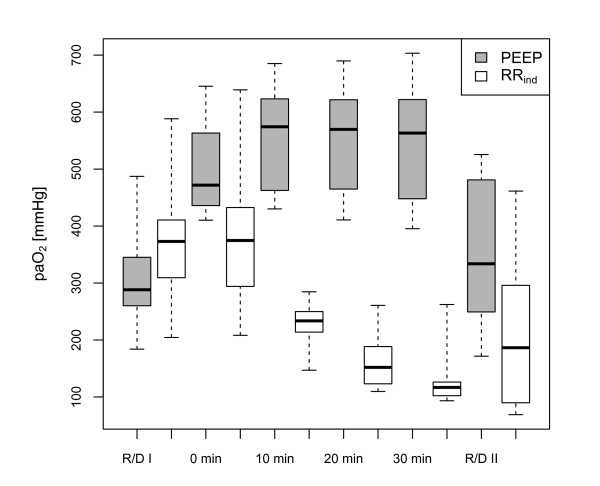
Time chart of the average paO2. Average paO2 (mmHg) after induction (R/D I), within 30 minutes of intervention and after re-induction (R/D II): a significantly decreased oxygenation develops following RRind intervention while PEEP induces a stable lung recruitment (padjusted < 0.001 after Bonferroni correction).